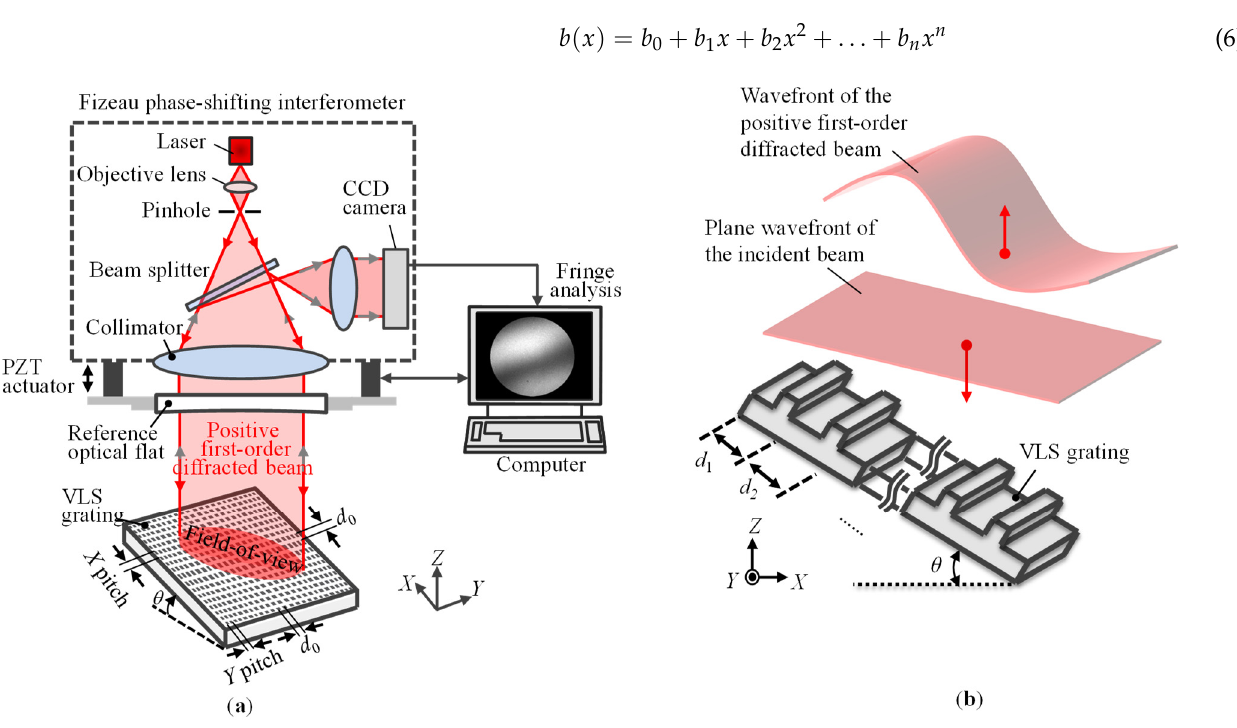
Figure 1. Measurement of the wavefront of the diffracted beam from a large-scale VLS grating: ( a ) Schematic of the measurement setup; ( b ) Wavefront of the diffracted beam from a typical VLS grating (The pitch variation subjects to second-order polynomial law).